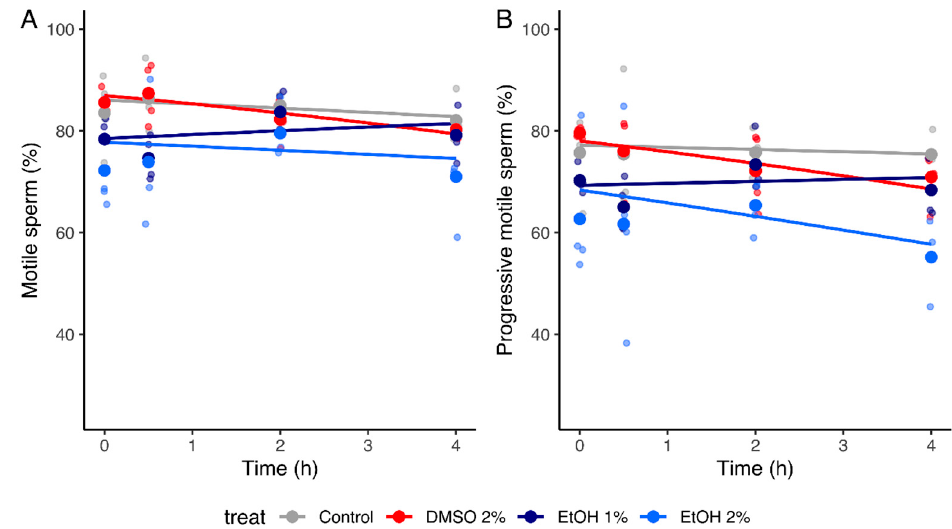
Figure 1. Influence of increasing concentrations of ethanol (EtOH) and dimethyl sulfoxide (DMSO) on total ( A , C ) and progressive ( B , D ) sperm motilities after a 4 h incubation. Values for each replicate (n = 8) are highlighted by a dot whose color refers to a donor. Colored lines represent the model fit for each donor. Black dots represent mean values for each concentration ± SD. Black lines correspond to the mean effect across all donors (Tables 2 and S3).